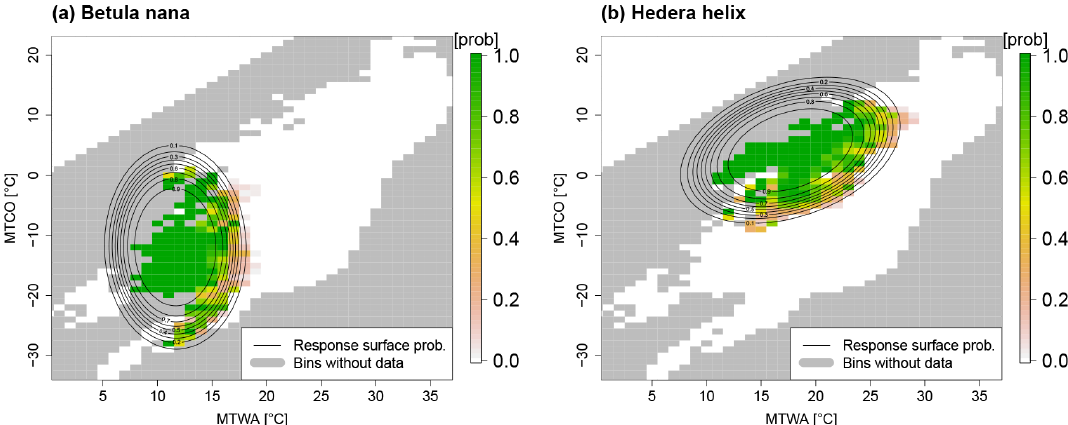
Figure 3. Response functions for (a) Betula nana and (b) Hedera helix . The relative frequency of occurrence in 1K bins is shown in colors, and the contours depict the probability of presence as estimated by the logistic response function. Gray boxes denote bins without calibration data. In the climate space, combinations of MTWA and MTCO with MTWA < MTCO cannot occur by definition. White bins in the upper left depict artificial absence information added to account for this